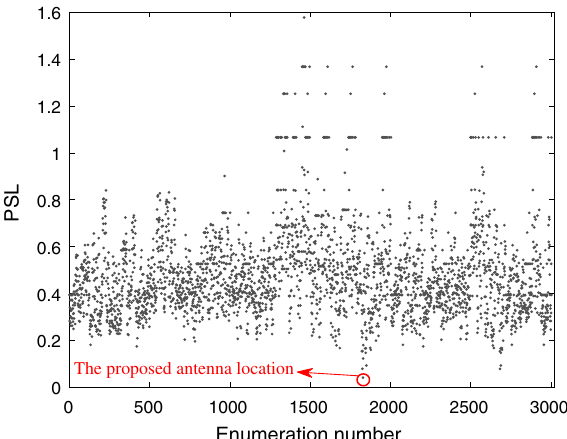
Fig. 6 The PSL of the synthesized beampattern under unit-PVPR constraint versus enumeration number in example 1